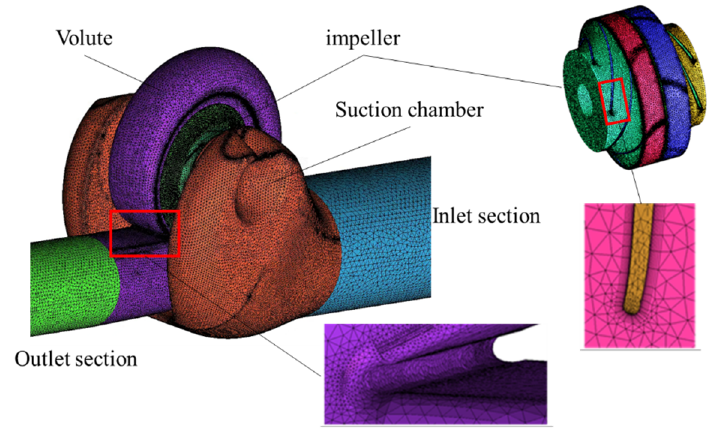
Figure 3. Grid of double-suction centrifugal pump.